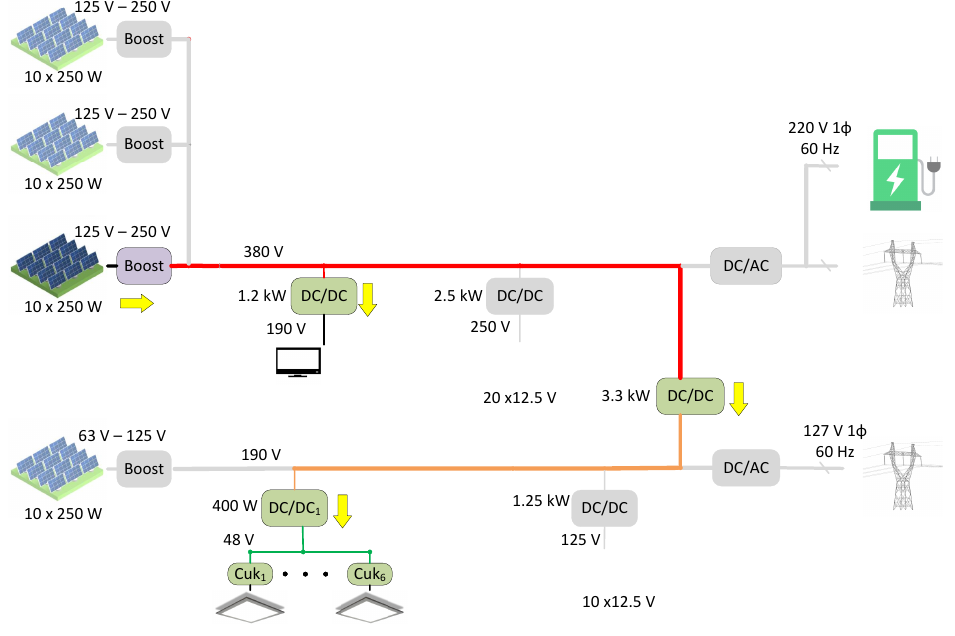
Figure 26. First test trajectory for DCMG multibus multi-voltage operating with only one boost